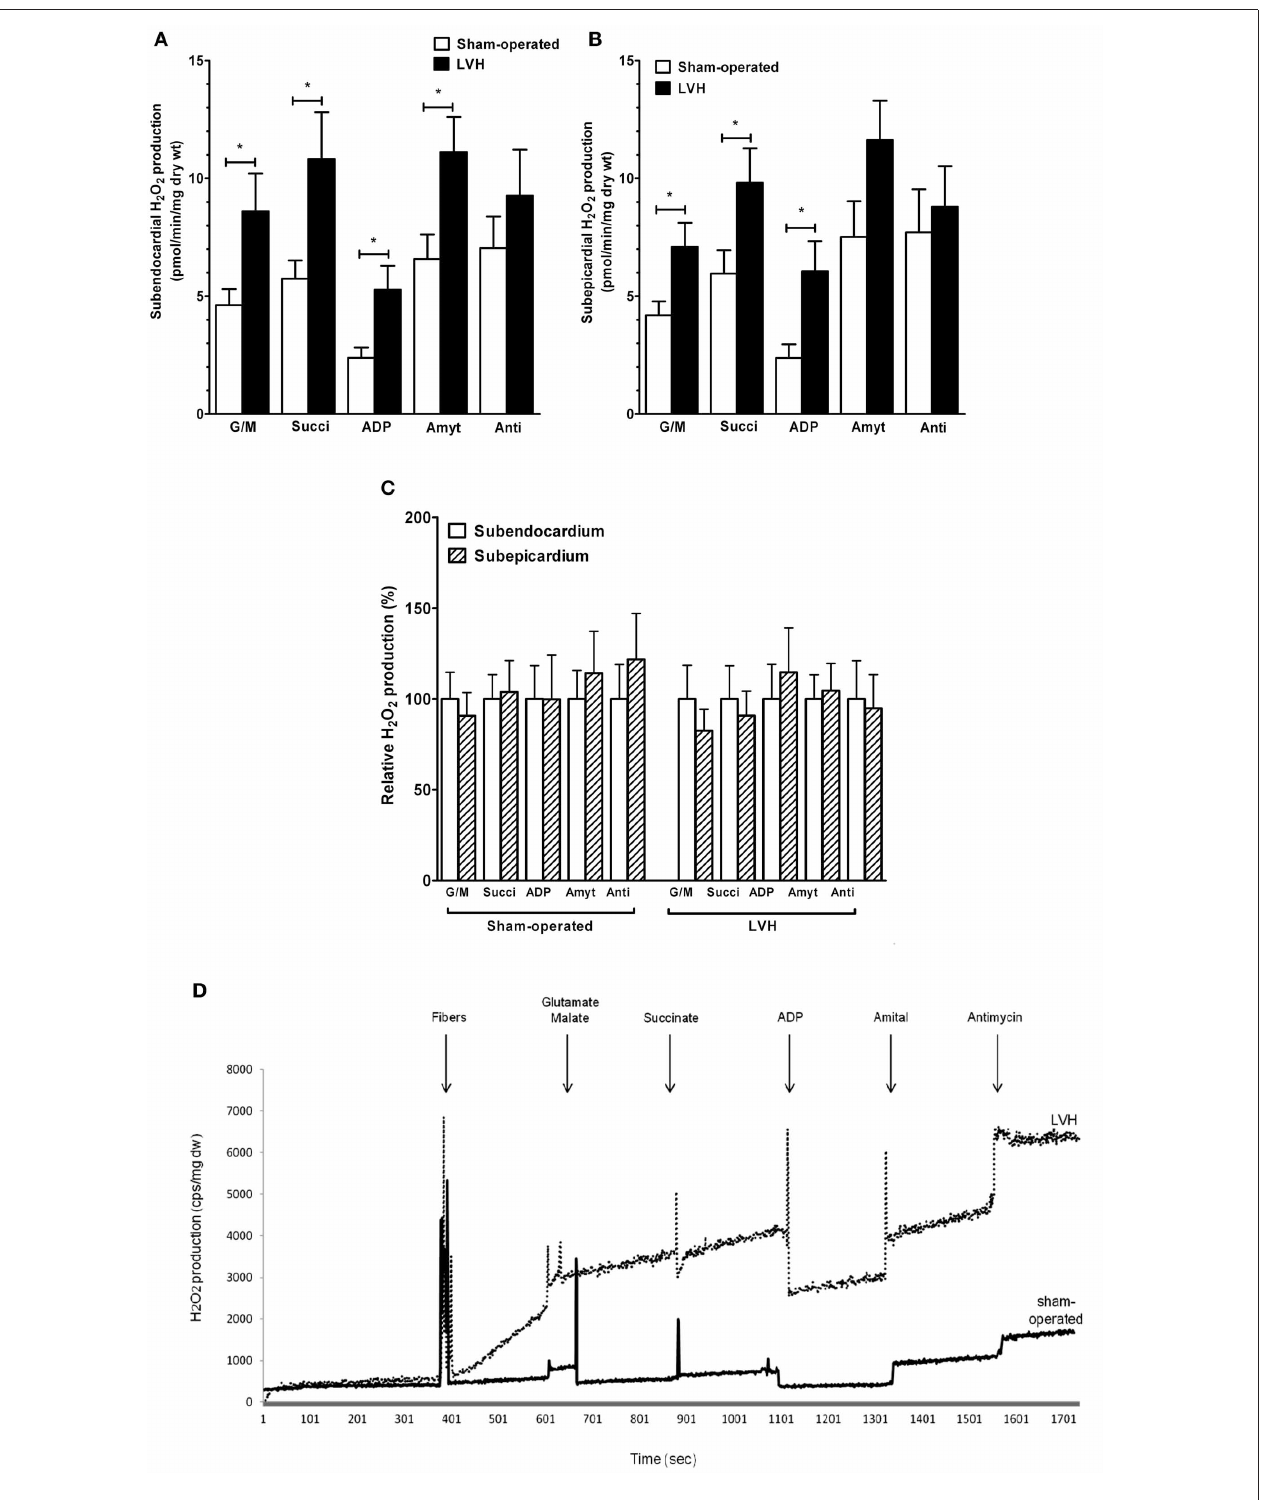
FIGURE 2 | Subendocardium and subepicardium hydrogen peroxide production in sham-operated and LV hypertrophy groups. (A) Mitochondrial H 2 O 2 production in subendocardium. (B) Mitochondrial H